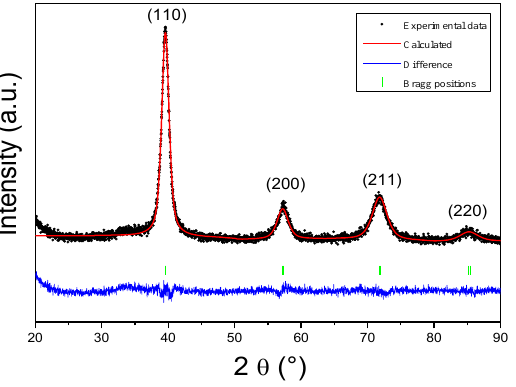
Figure 10. XRD ( λ = 1.5406 Å) of the Ti 0.30 V 0.25 Zr 0.10 Nb 0.25 Mo 0.10 after 20 cycles (desorbed state) with the corresponding Rietveld analysis.